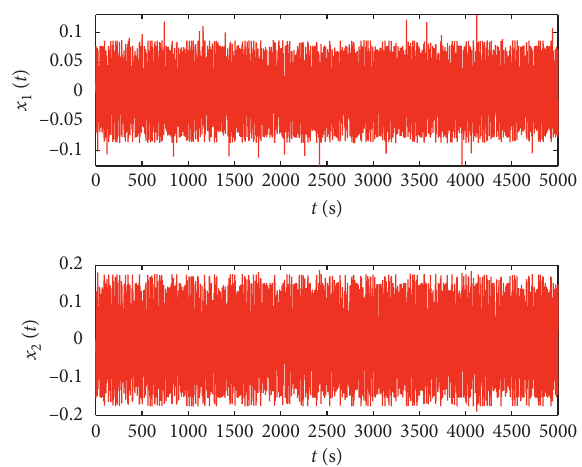
Figure 8: The time responses of state variable x ( t ) of Markov jump system (72) for Case 1.